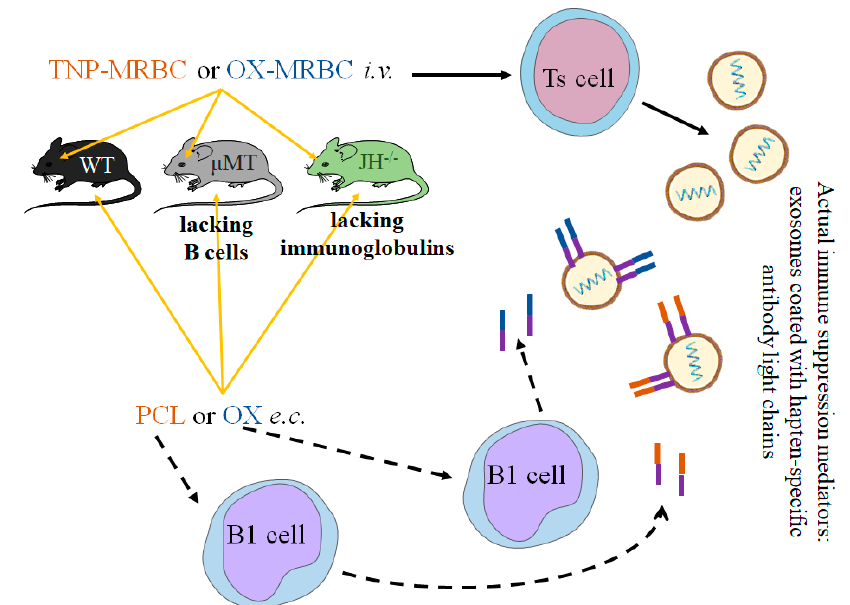
Figure 6. Summary figure depicting the role of hapten-specific antibody light chains secreted by B1 cells in immune suppression mechanism mediated by suppressor T (Ts) cell-derived exosomes. Epicutaneous (e.c.) sensitization of wild type (WT) mice with picryl chloride (PCL, trinitrophenol chloride) or oxazolone (OX) activates B1 cells to release hapten-specific antibody light chains that coat suppressive exosomes, which ensures hapten-specificity of exosome-mediated immune regulatory mechanism. This was proved by employing B-cell-deficient µMT and pan immunoglobulin-deficient JH − / − mice, which Ts cells, after tolerization with hapten-coupled syngeneic mouse red blood cells (MRBC), produced exosomes that were nonsuppressive, unless in vitro supplemented with antibody light chains.